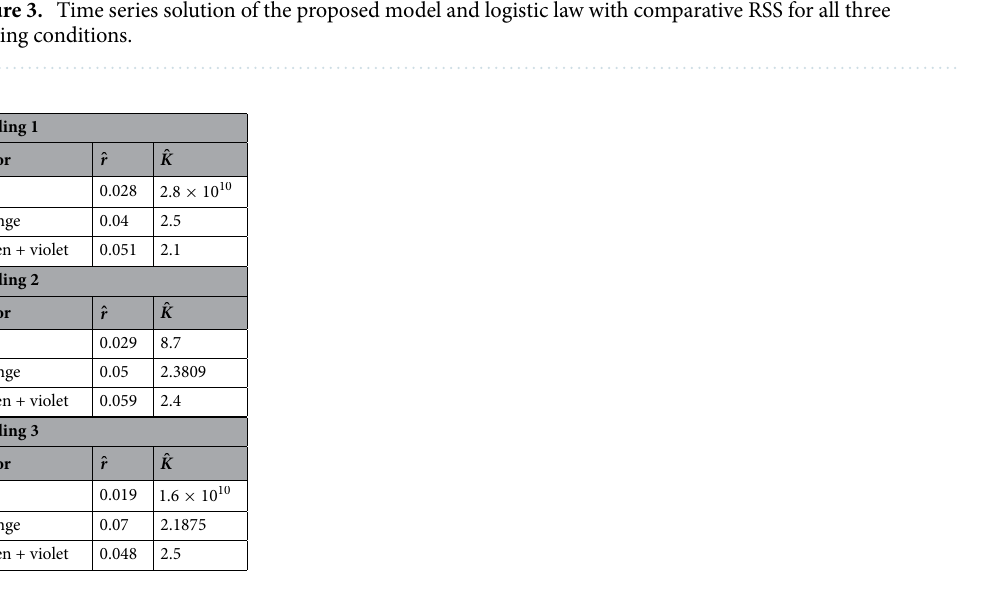
Table 4. Logistic model fitting with the Jin et al. 1 estimates used in Fig. 3 with the specific